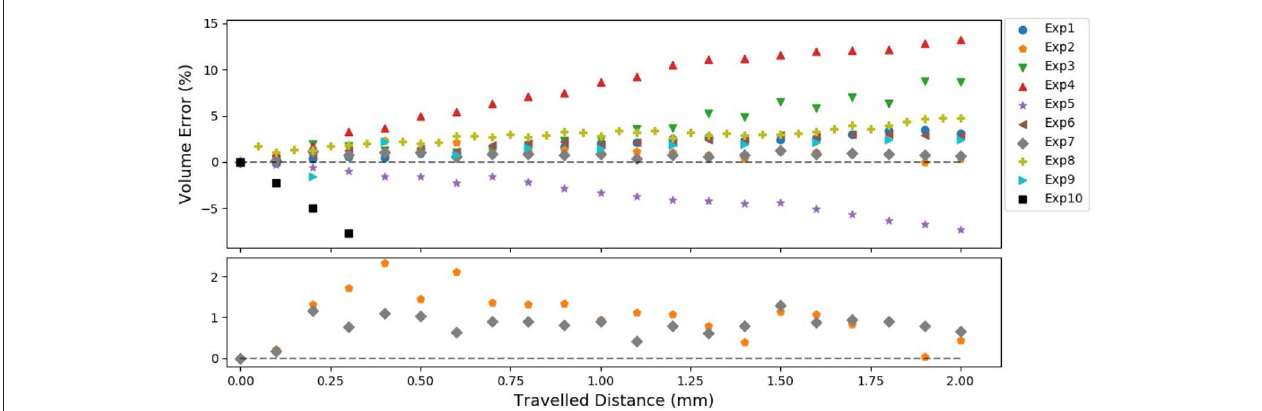
FIGURE 6 | Volume error of the advected sphere, expressed in percent of its initial volume. The orange pentagons and gray rhombuses correspond to the best parameterizations for mass conservation, and the black squares to an advection experiment without the ICLS method. The specific parameters of the other simulations are given in Table 1 . The lower panel is a zoom to the best simulation results.